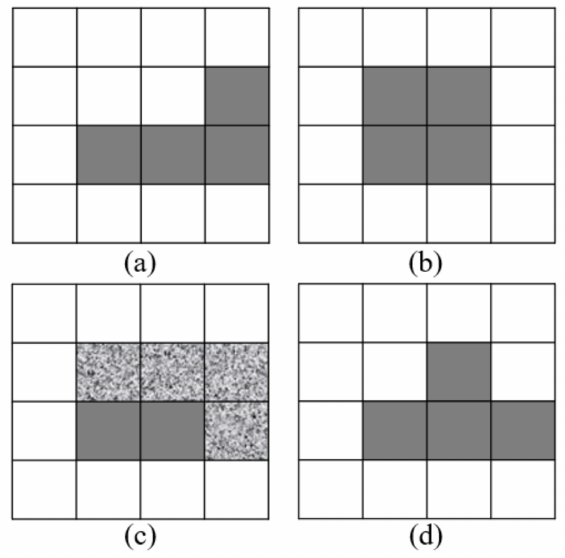
Figure 7. An example to explain the GA process. An example illustrating the GA process. ( a , b ) initial parental genes, ( c ) predicted offspring genes; ( d ) generated offspring genes.